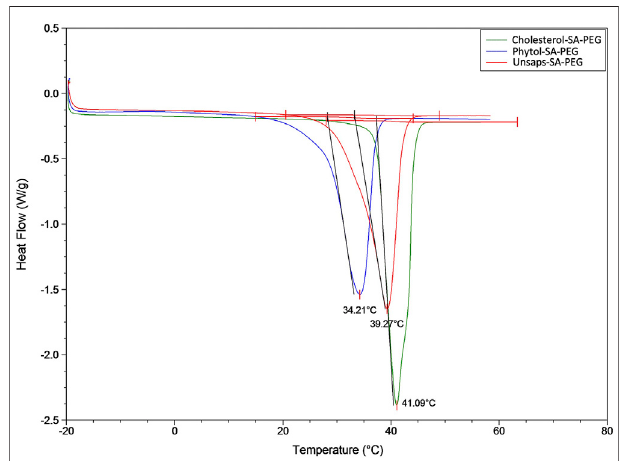
FIGURE 6 | Differential scanning calorimetry pro fi les of each of the fi nal products: carboxyethyl esters of cholesterol, phytol, and unsaponi fi able surfactant derivatives, shown as succinic anhydride-PEG esters.